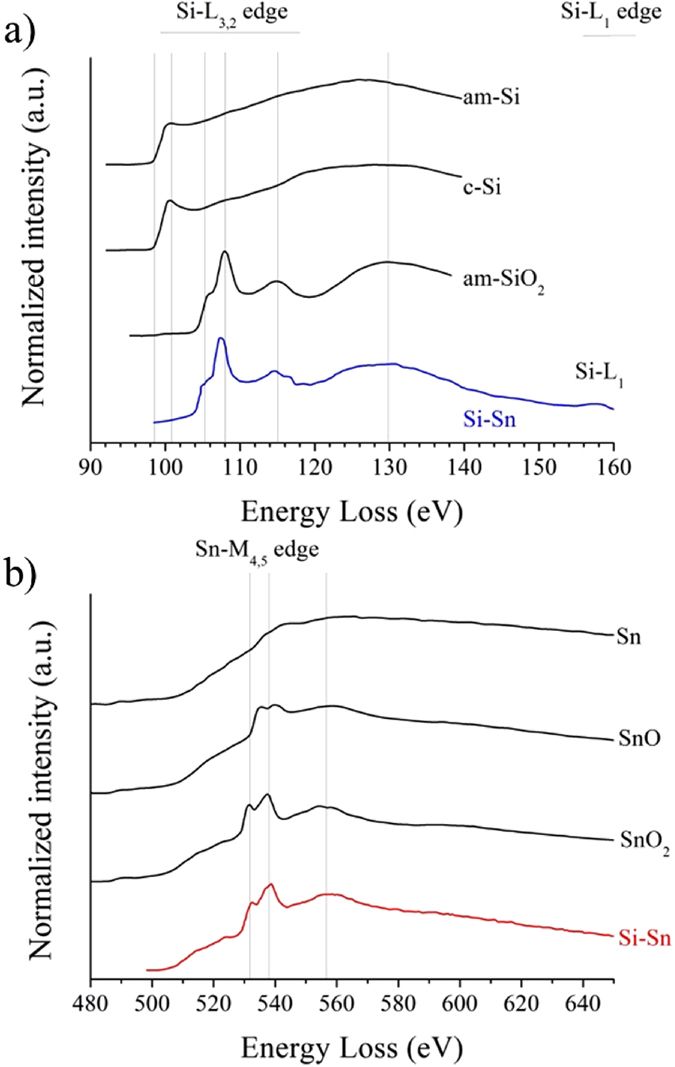
(a) EEL spectra at the Si-L3,2 edge of a representative sample synthesized with a current of 1 A. Reference spectra (amorphous and crystalline silicon and amorphous SiO2) taken from4 are given for comparison. (b) EEL spectrum at the Sn-M4,5 edge of a representative sample synthesized with a current of 1 A. Reference spectra taken from5 are given for comparison.